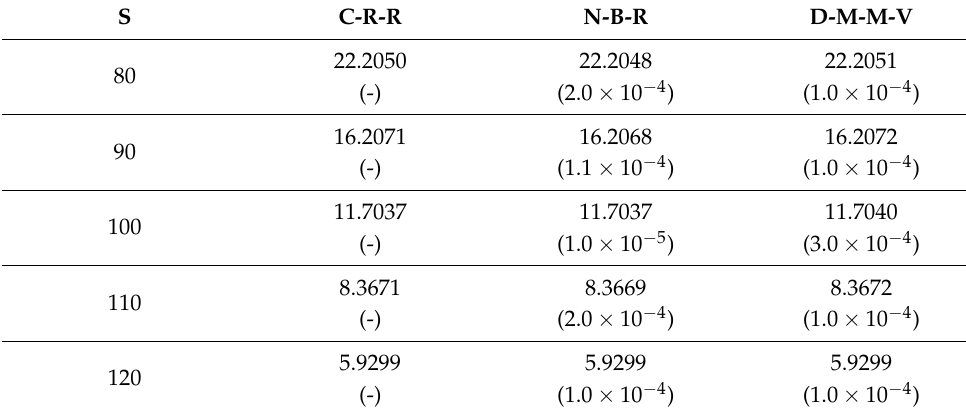
Table 2. Comparison between N-B-R and D-M-M-V: S as in the first column, T = 3, σ = 0.2, r = 0.08, K = 100 and δ = 0.08. The benchmark value was obtained considering the C-R-R model with n = 10,000 time steps. For each value of S , the resulting approximation errors are displayed in the second rows within